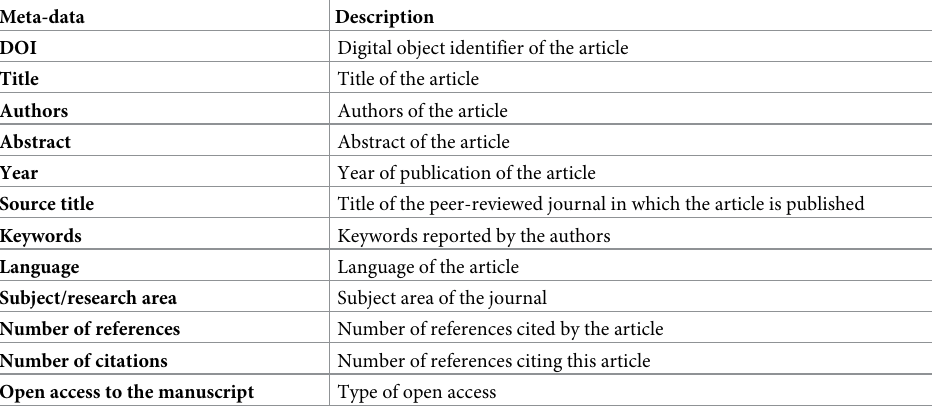
Table 3. Meta-data exported from WOS and Scopus.